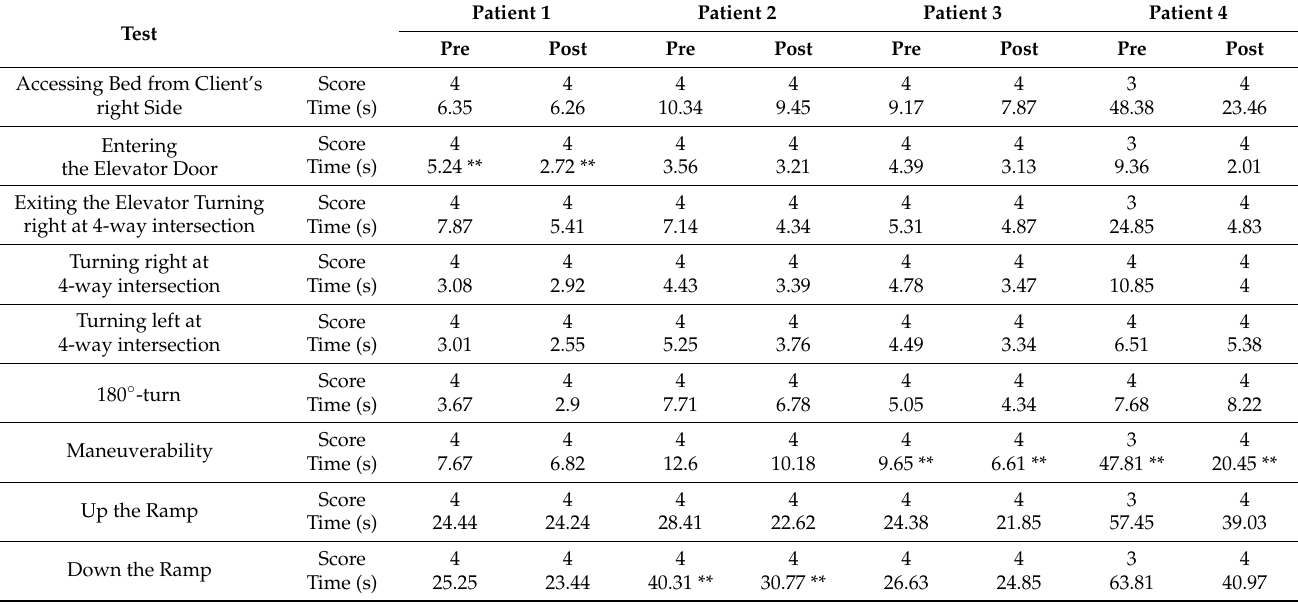
Table 3. Modified Power Mobility Indoor Driving Assessment (PIDA).